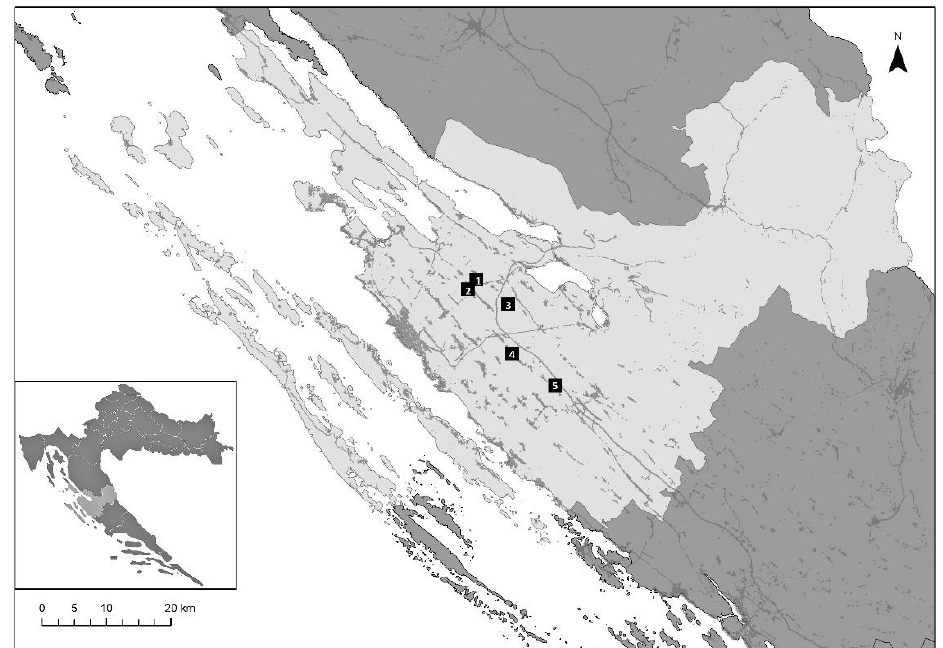
Figure 1. Map showing five sites (black squares), in Zadar County in the Mediterranean part of Croatia, selected for field research and sampling. The site within the natural habitat is located near Poličnik (C) (1), the olive orchards are located in Poliˇcnik (OE) (2) and Škabrnja (OI) (5), the vineyards in Baštica (VI) (2) and Nadin (VE) (4).